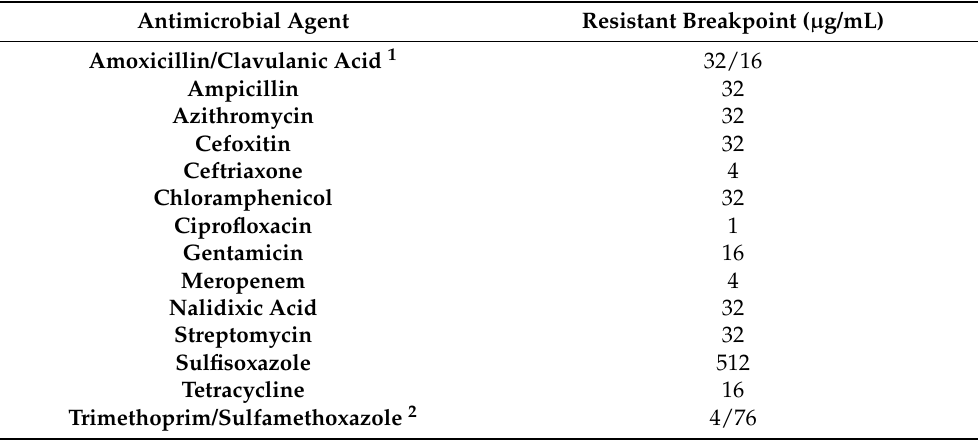
Table 1. Resistant breakpoint concentrations of antimicrobial agents used for Salmonella